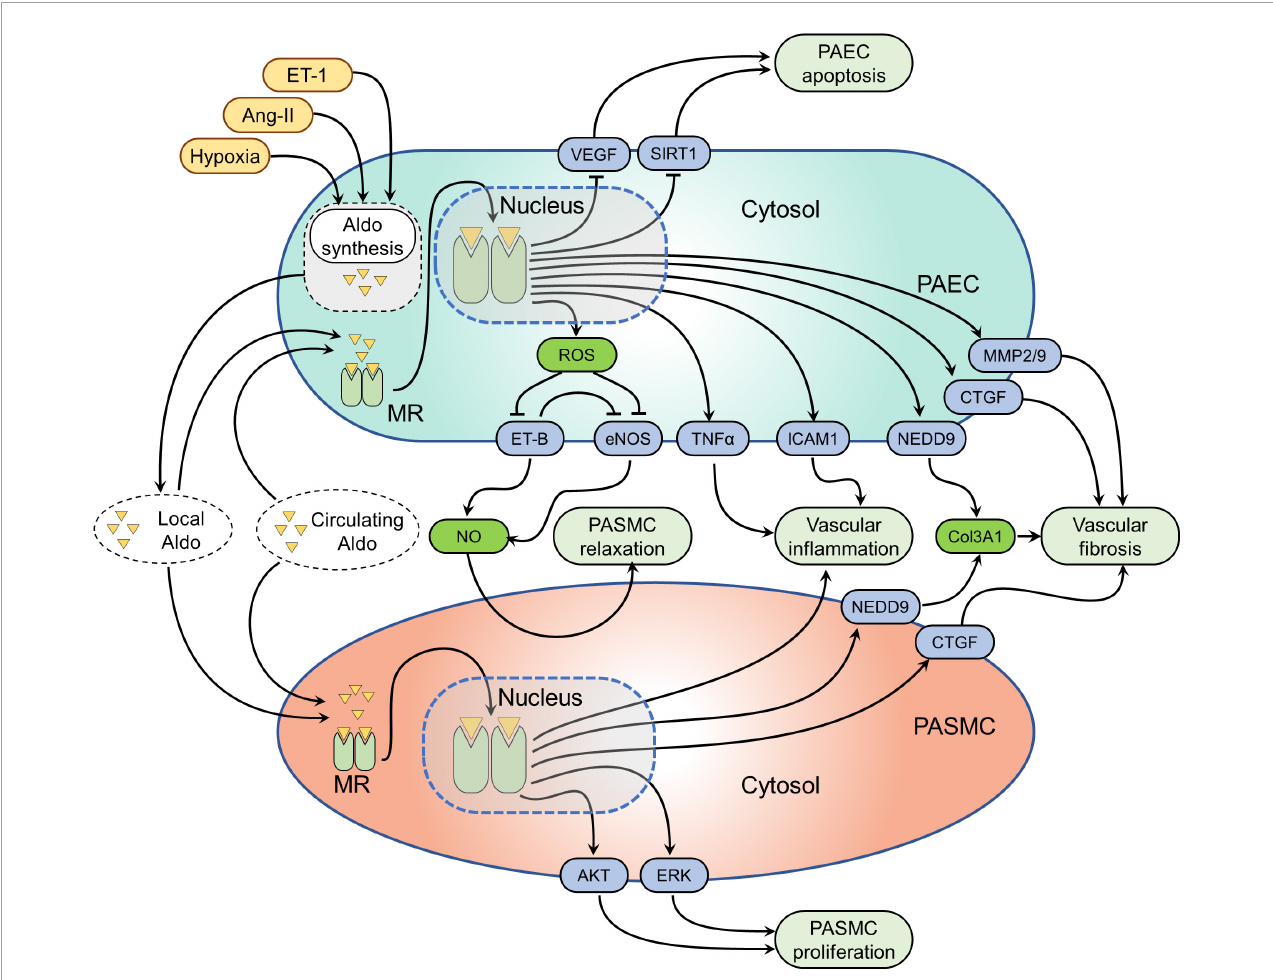
FIGURE2 Mineralocorticoid receptor (MR)-mediated signaling pathways in pulmonary vascular cells. Several factors such as hypoxia, angiotensin-II (Ang-II), and endothelin-1 (ET-1) have been shown to induce aldosterone synthesis in pulmonary artery endothelial cells (PAECs). Both locally synthesized aldosterone and circulating aldosterone can activate MR in PAECs and PA smooth muscle cells (PASMCs). Activation of the MR alters several signaling pathways in pulmonary vascular cells. The effected pathways in PAECs are the following: (1) MR-induced reactive oxygen species (ROS) formation, which in turn inhibits endothelial nitric oxide synthesis (eNOS) and endothelin receptor B (ET-B) resulting in decreased nitric oxide (NO) formation. The resulting effect of decreased NO bioavailability is increased pulmonary vascular SMC (PASMC) contractility; (2) MR activation inhibits VEGF and sirtuin 1 (SIRT1) resulting in PAEC apoptosis; (3) MR leads to the overexpression neural precursor cell expressed developmentally down-regulated protein 9 (NEDD9), connective tissue growth factor (CTGF), matrix metalloproteinase-2 and 9 (MMP2/9) causing pulmonary vascular fibrosis; (4) MR also induces tumor necrosis factor alpha (TNF α ) and intercellular adhesion molecule-1 (ICAM-1) overexpression, resulting in pulmonary vascular inflammation. While the MR effected pathways in PASMCs include: (1) MR activation leads to pulmonary vascular inflammation through unknown mechanisms; (2) MR induced neural precursor cell expressed developmentally down-regulated protein 9 (NEDD9) and CTGF activation cause pulmonary vascular fibrosis; (3) while MR-mediated activation of protein kinase B (AKT) and extracellular signal-regulated kinase (ERK) signaling pathways cause increased PASMC